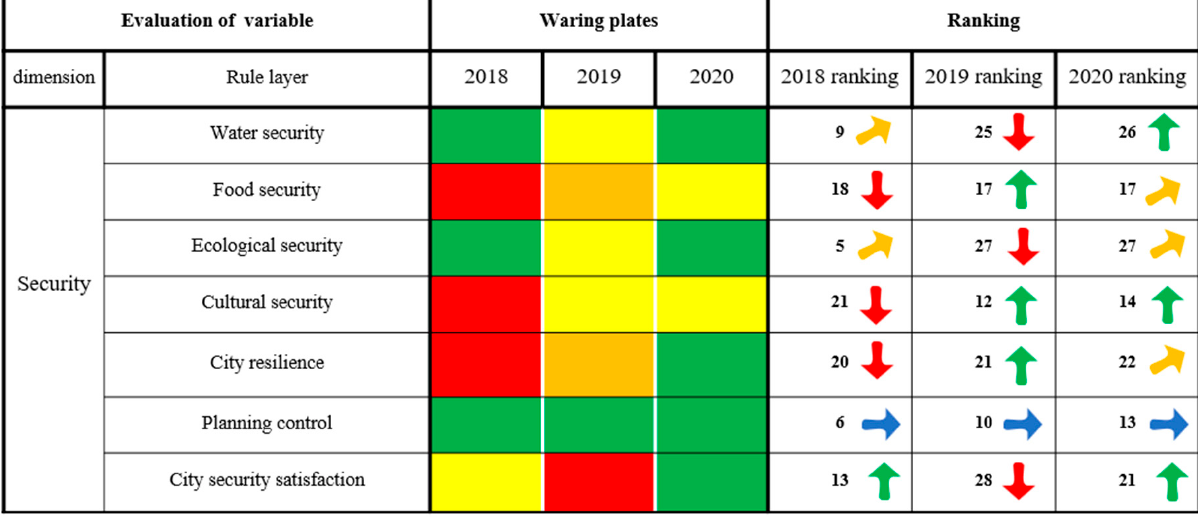
Figure 6. The results of the security dimension of city health examination and evaluation in Xining City.